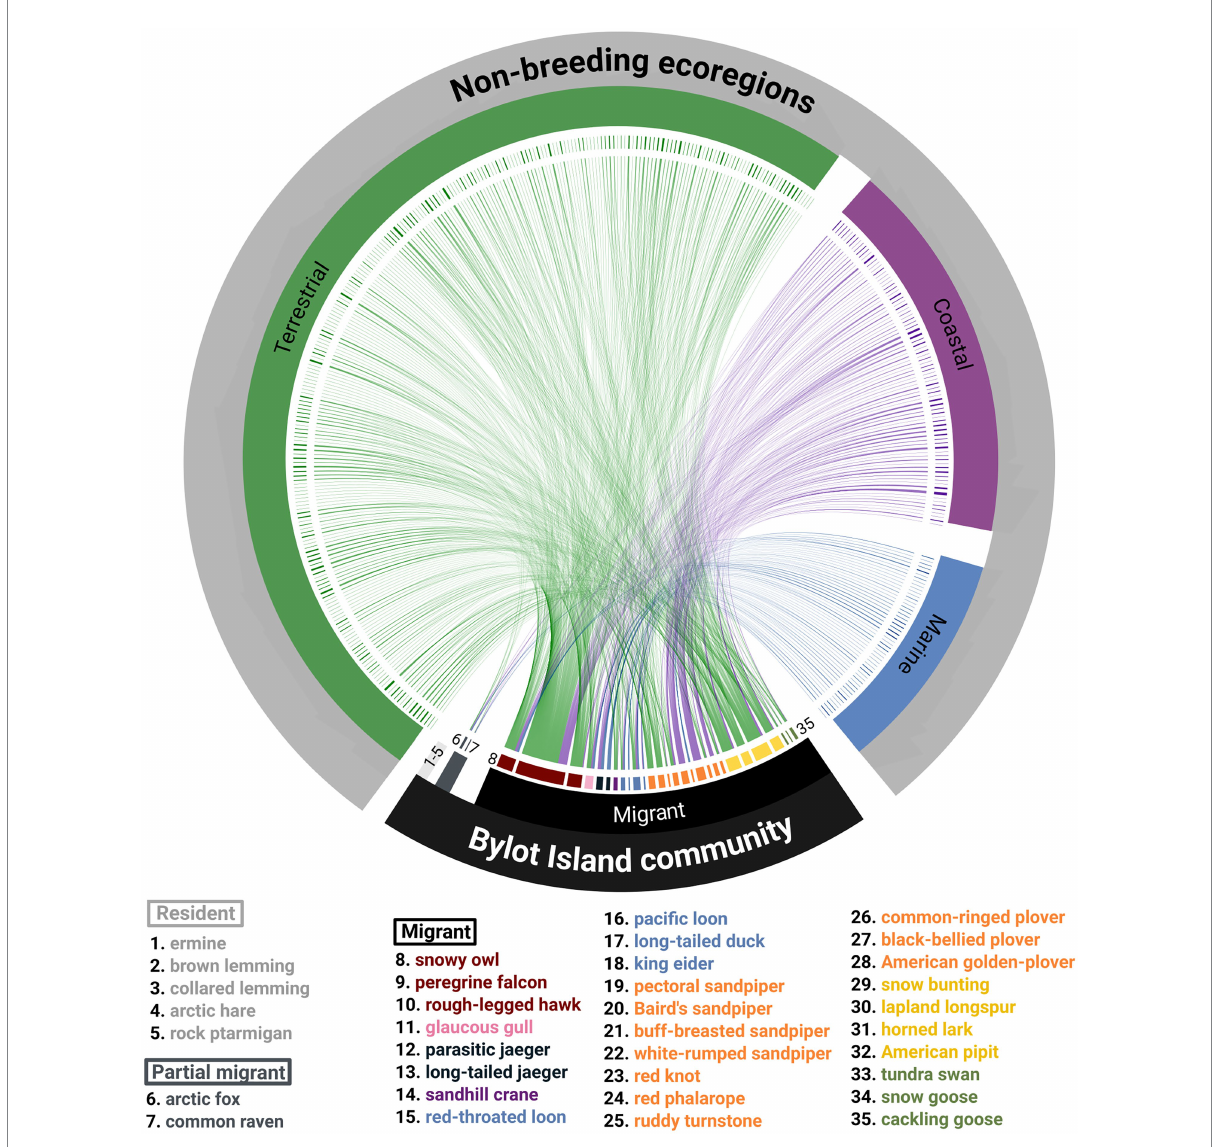
FIGURE 5 Community migration network of Bylot Island with the 35 species labeled in an anticlockwise way and the 393 biogeographic ecoregions colored by type (green = terrestrial, purple = coastal and blue = marine). Migratory species were colored based on their functional groups (red = raptors, pink = gulls, purple = cranes, dark blue = jaegers, light blue = ducks and loons, orange = shorebirds, yellow = passerines, green = geese and swans). The chord diagram representation was done with the R package circlize (Gu et al.,